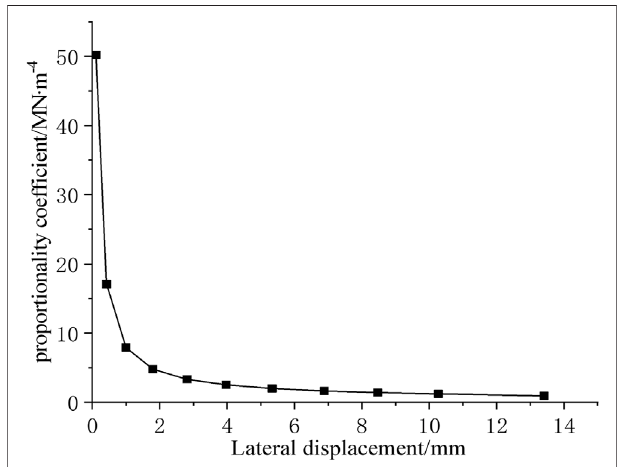
FIGURE 9 | Bending moment diagram of the pile under horizontal static load.